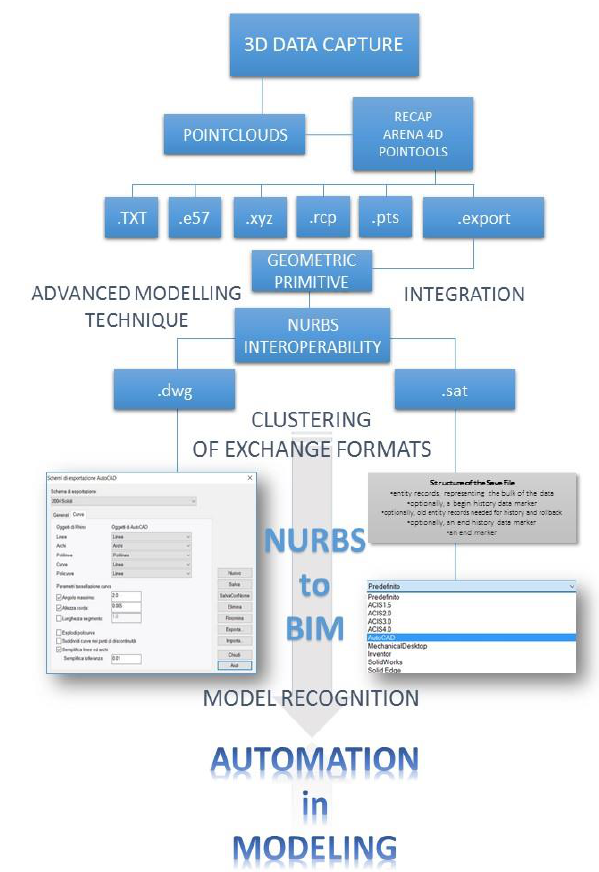
Fig. 5. Automation in modelling. Clustering of exchange formats and their schemas ( .dwg. and .sat ).